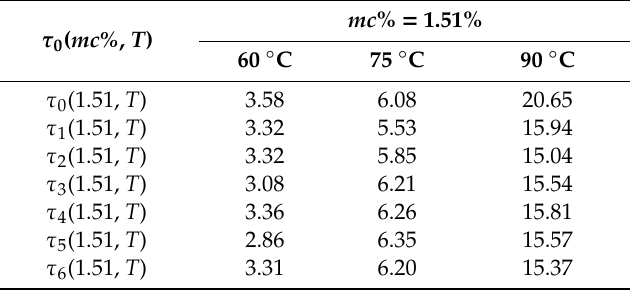
Table 7. Calculation result of the normalized parameters of verification sample.